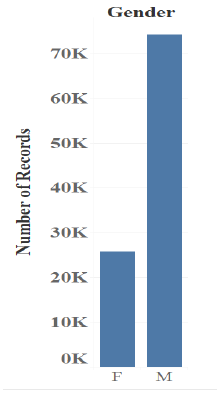
Figure 4. MovieLens gender distribution.